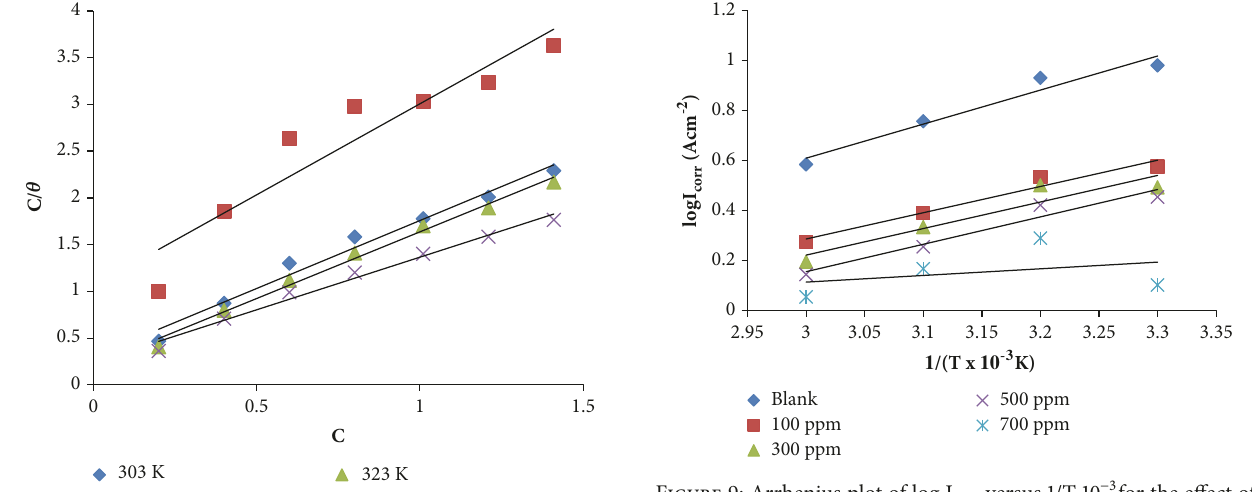
Figure 9: Arrhenius plot of log I corr versus 1/T 10 −3 for the effect of temperature on the performance of BFC on brass in 1M